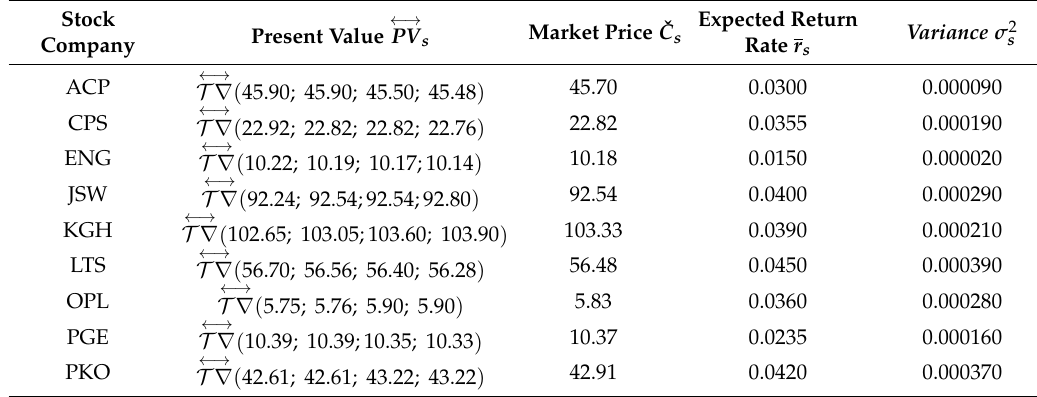
Table 1. Evaluation of portfolio π